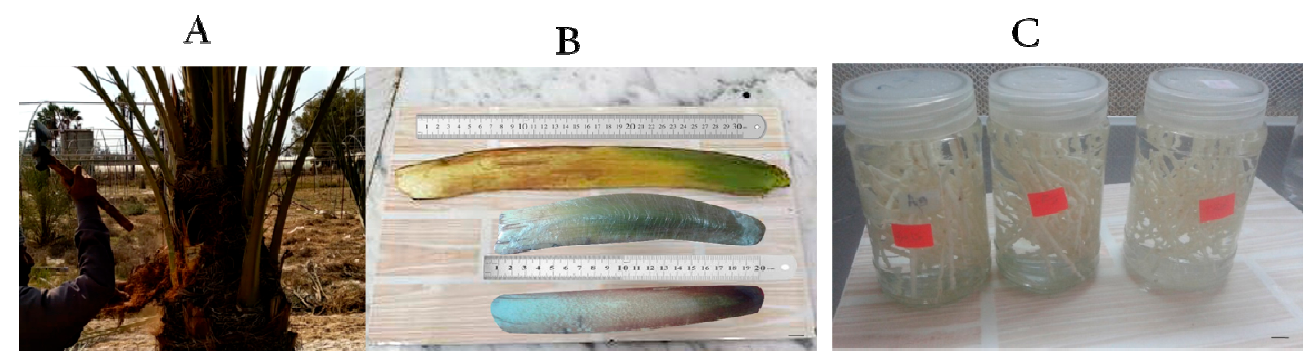
Figure 8. Preparation of immature female inflorescence tissues for date palm micropropagation: ( A ) Spathe harvesting during flowering period. ( B ) Sterilized spathes ready to be opened under aseptic conditions. ( C ) Immature female inflorescence disinfection in sodium hypochlorite solution. Scale bar: 1 cm.